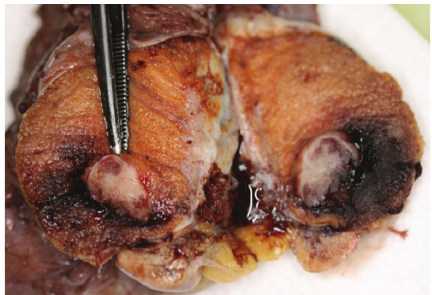
Figure 2: Macroscopic aspects of the benign testicular tumor.